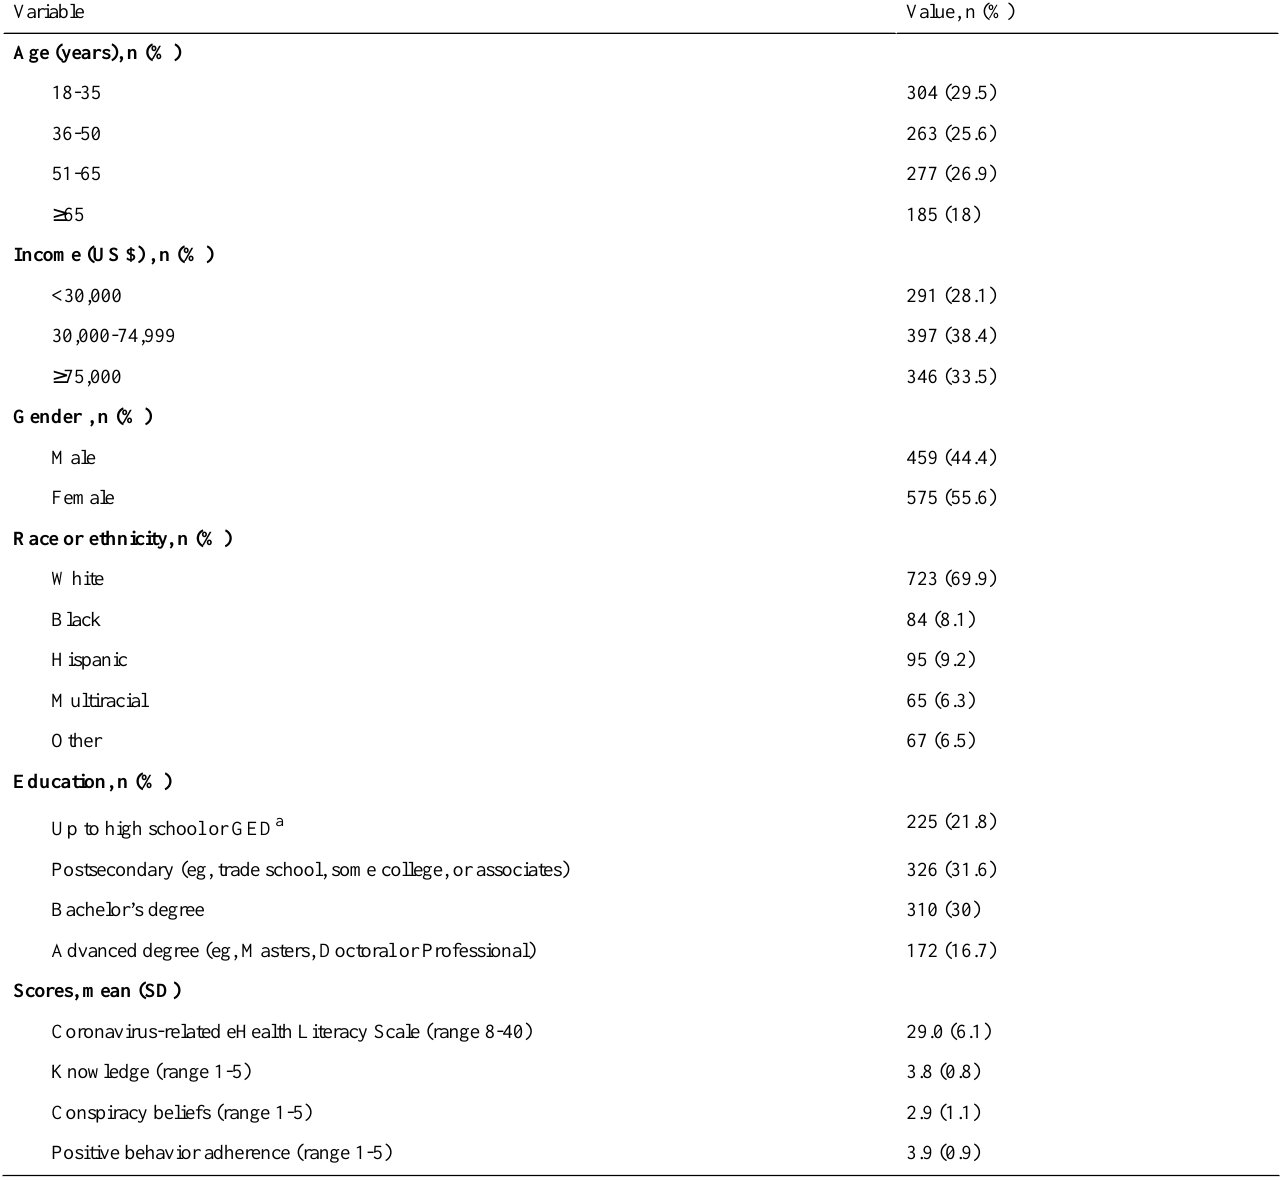
Table 1. Characteristics of study participants (N=1074) and their mean scores for various study